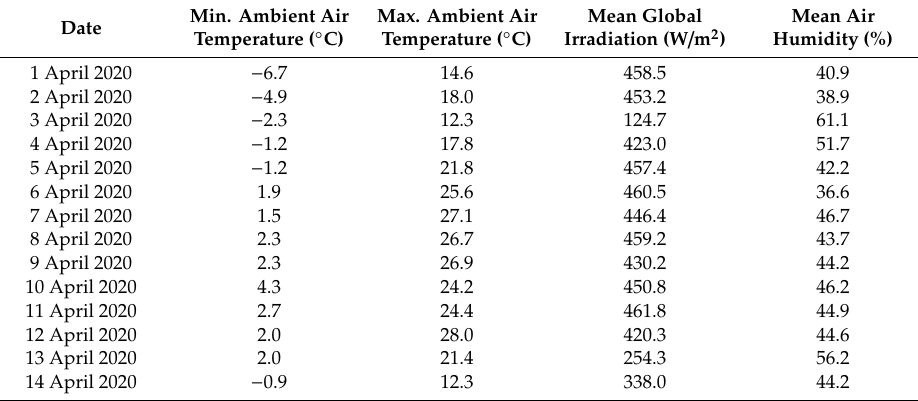
Table A5. Measured boundary conditions in April